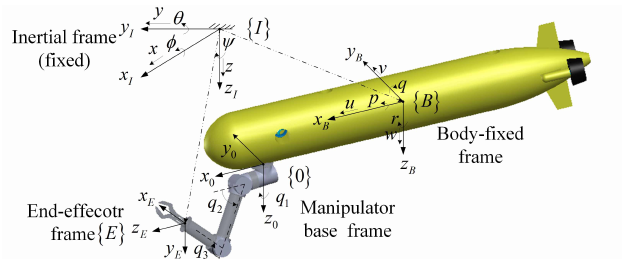
Figure 1. Coordinate systems of the underwater vehicle manipulator system